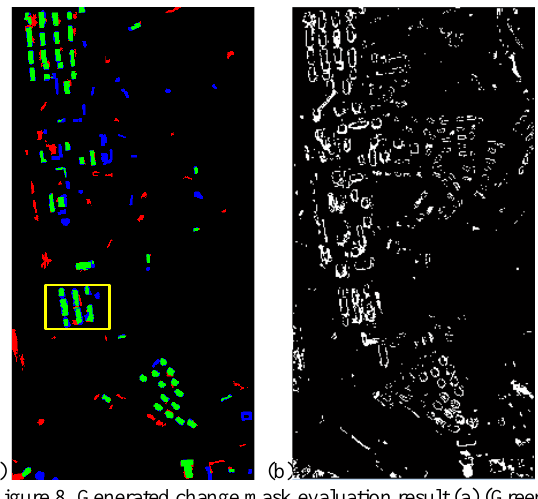
Figure 8. Generated change mask evaluation result (a) (Green: true detected; red: false positive; blue: false negative; black: true negative), and detected outliers